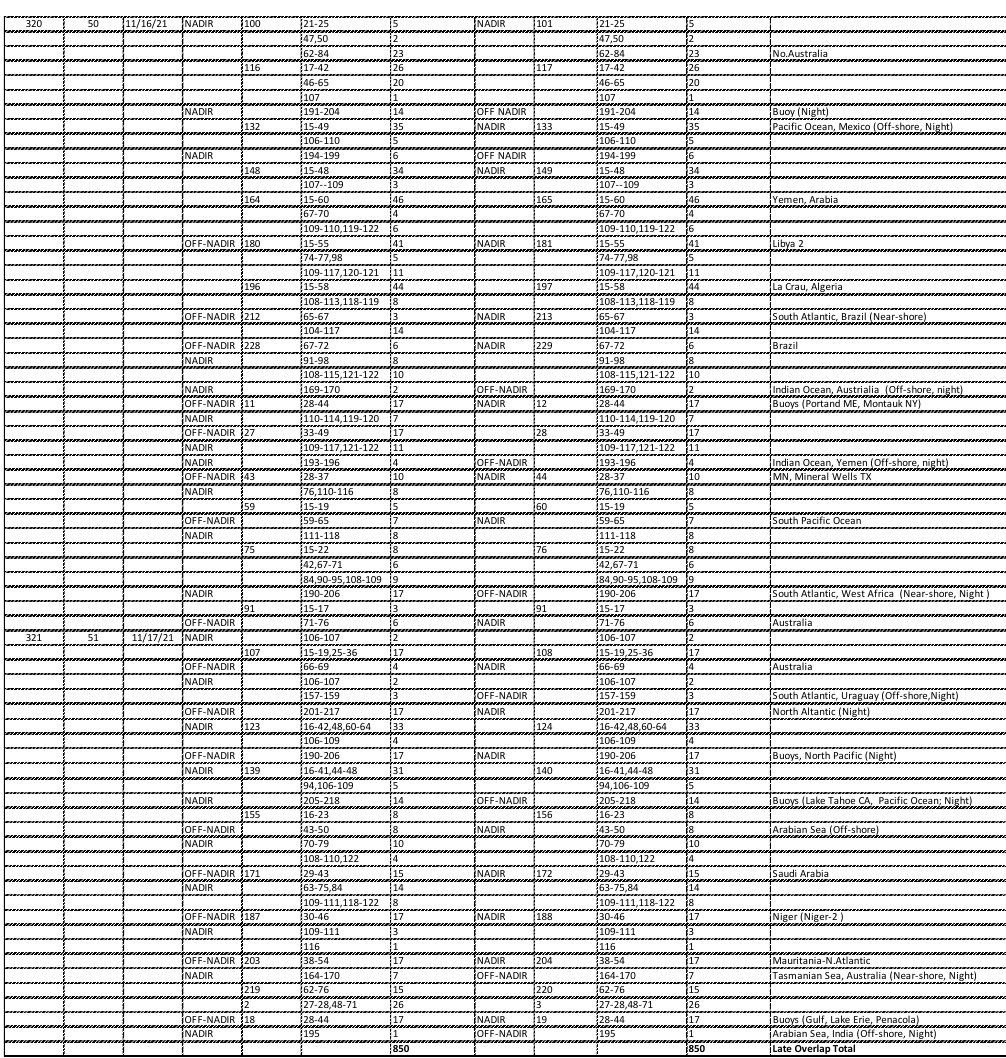
Figure A1. Summary of Tandem flying pair acquisitions.